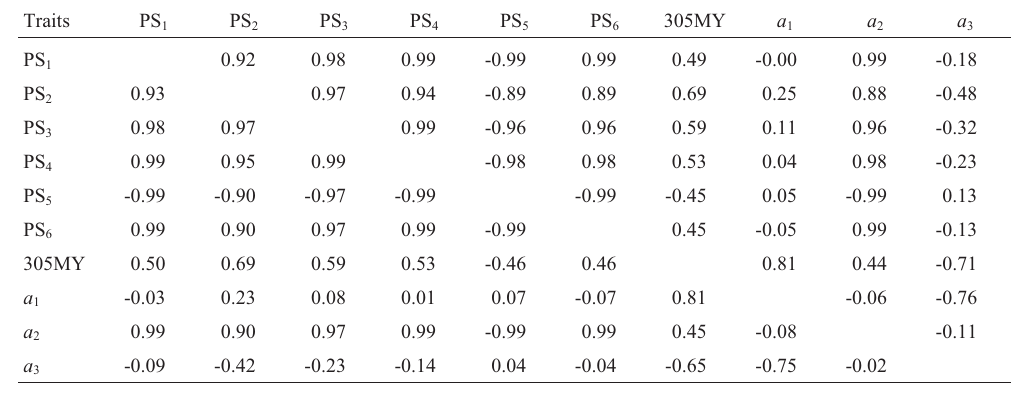
Table 4 - Rank correlation between estimated breeding values for different measures of persistency of lactation (PS 1 to PS 6 ), 305-day milk yield (305MY) and random regression genetic coefficients ( a 1 , a 2 and a 3 ) of sires (upper diagonal) and cows (lower diagonal). Traits